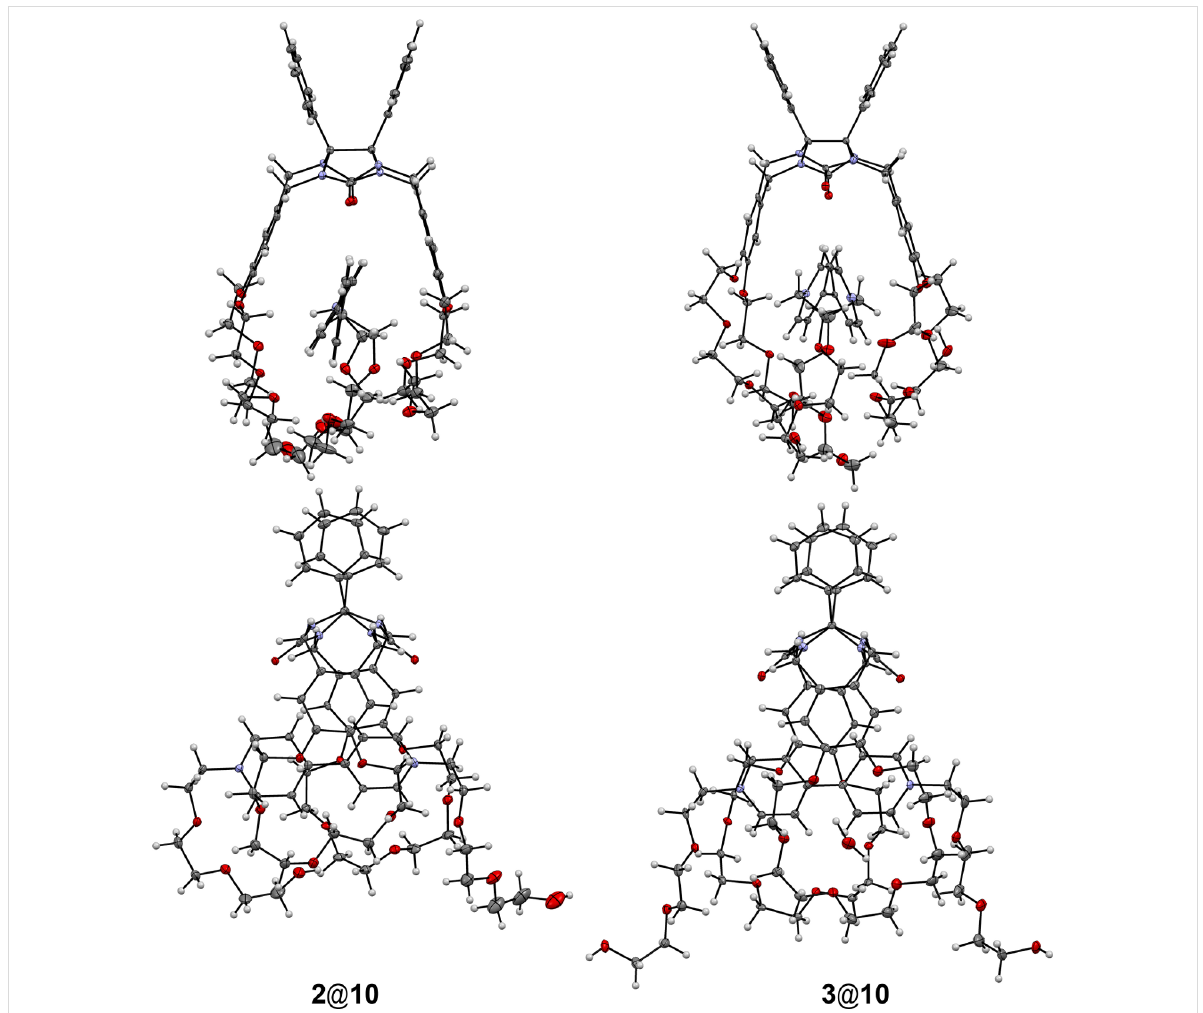
Figure 10: Molecular structures of complexes 2 @ 10 and 3 @ 10 . Anions and solvate molecules are omitted for clarity.